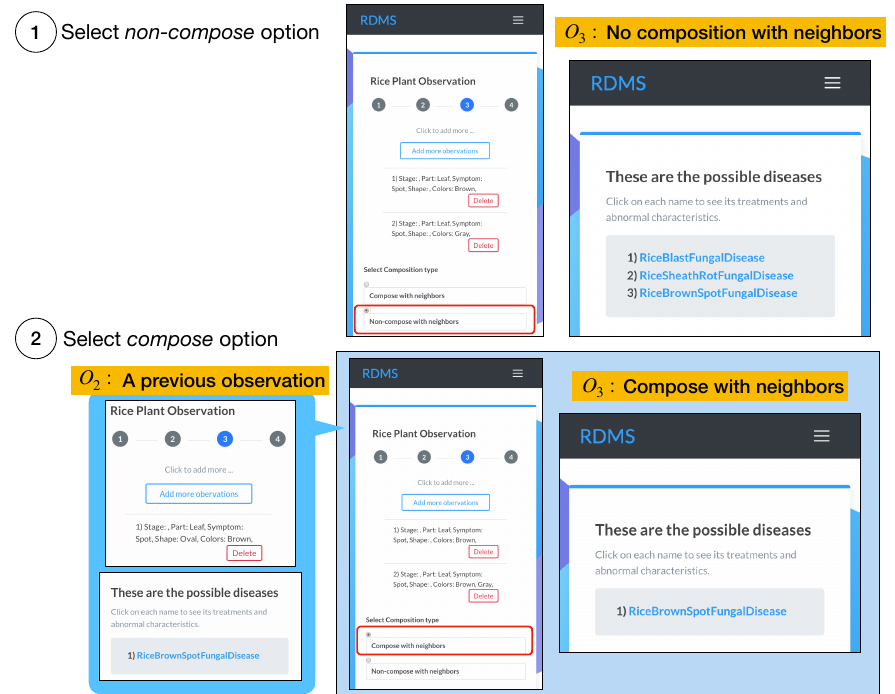
Figure 8. The usage of our composition function: (1) selecting the non-composition option and (2) selecting the composition